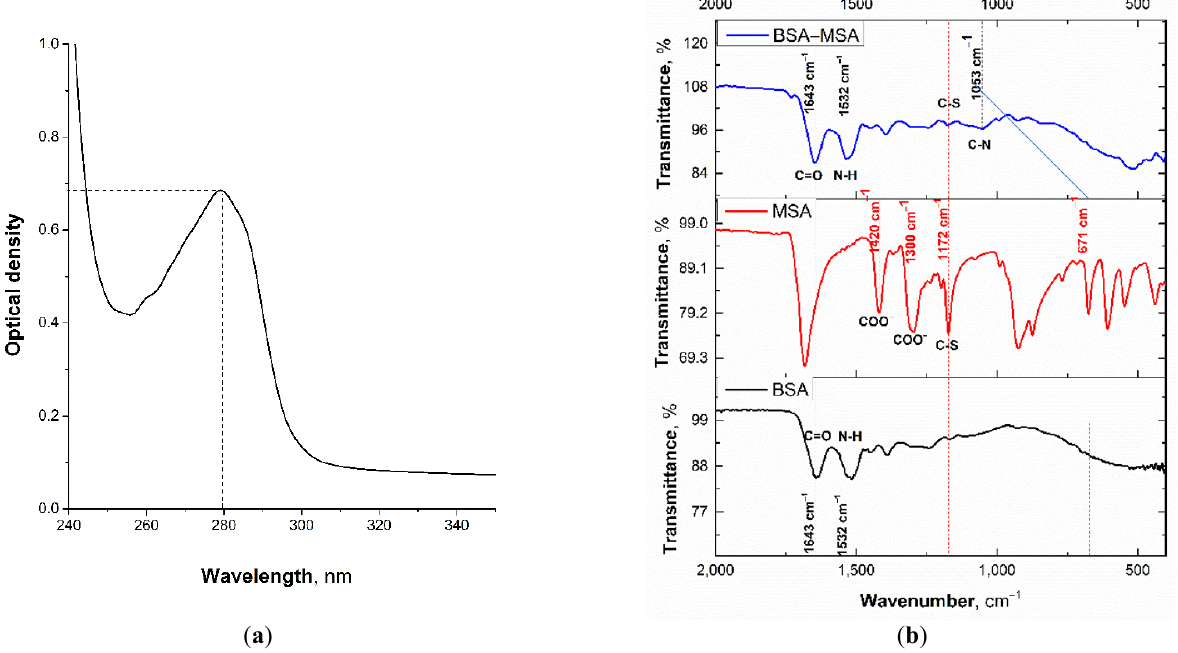
Figure 4. The UV-spectrum of BSA–MSA ( a ) and FTIR spectra of pure BSA (black curve), MSA (red curve), and BSA–MSA (blue curve) ( b ).